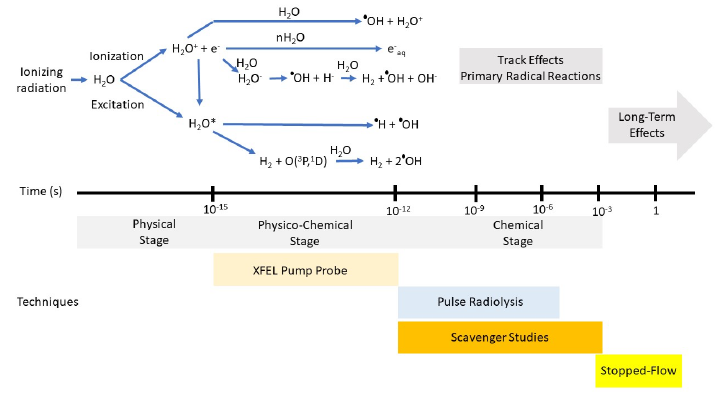
Figure 1. Top: Various stages that occur in the radiolysis of water by fast ions or electrons or energetic photons. Energy loss by the incident radiation to produce ionized or excited states of the medium is considered to occur in the physical stage that is best described in terms of cross sections. The relaxation of the medium from a few femtoseconds to about a picosecond is considered the physico-chemical stage and represents the true beginning of the formation of chemically reactive species and that can be examined by XFELs. From top to bottom, these processes following ionization of the water molecule are the proton transfer to produce the OH radical, hydration of the electron, and dissociative electron attachment. Neutralization of the electron with the water cation or direct excitation will lead to the excited water molecule followed by two most probable reactions shown. Reaction scheme and time scales taken from Ref. [30]. Bottom: Techniques used to probe chemical phenomena at various